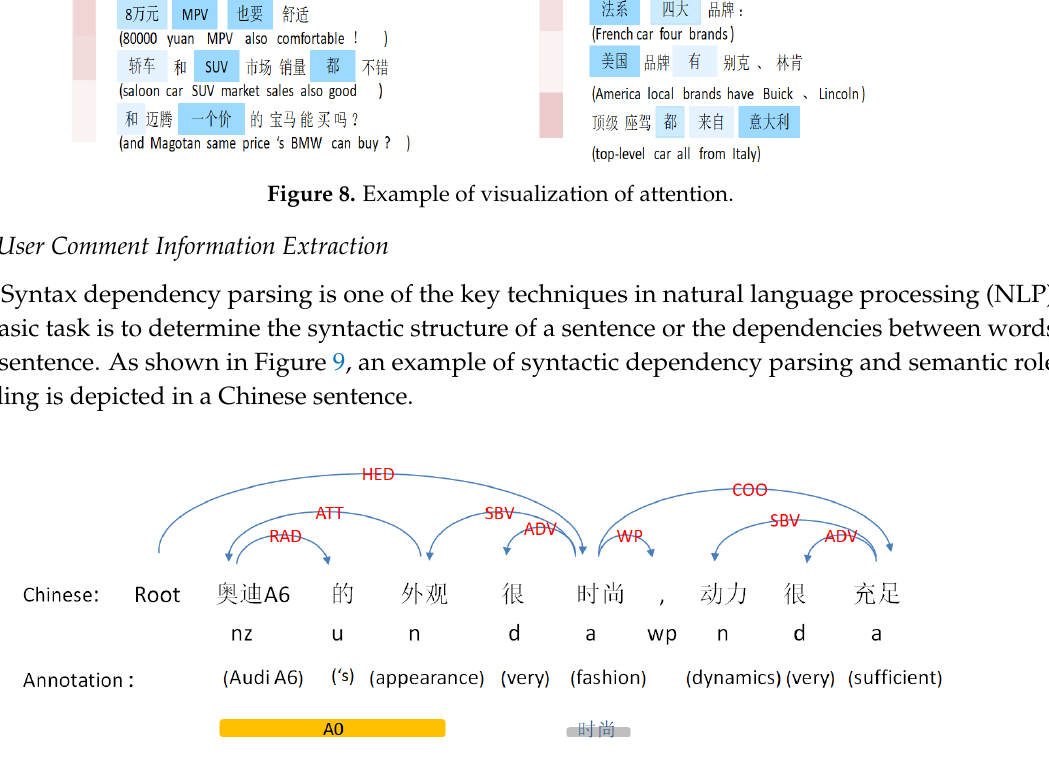
Figure 9. An example of syntax dependency parsing and semantic role